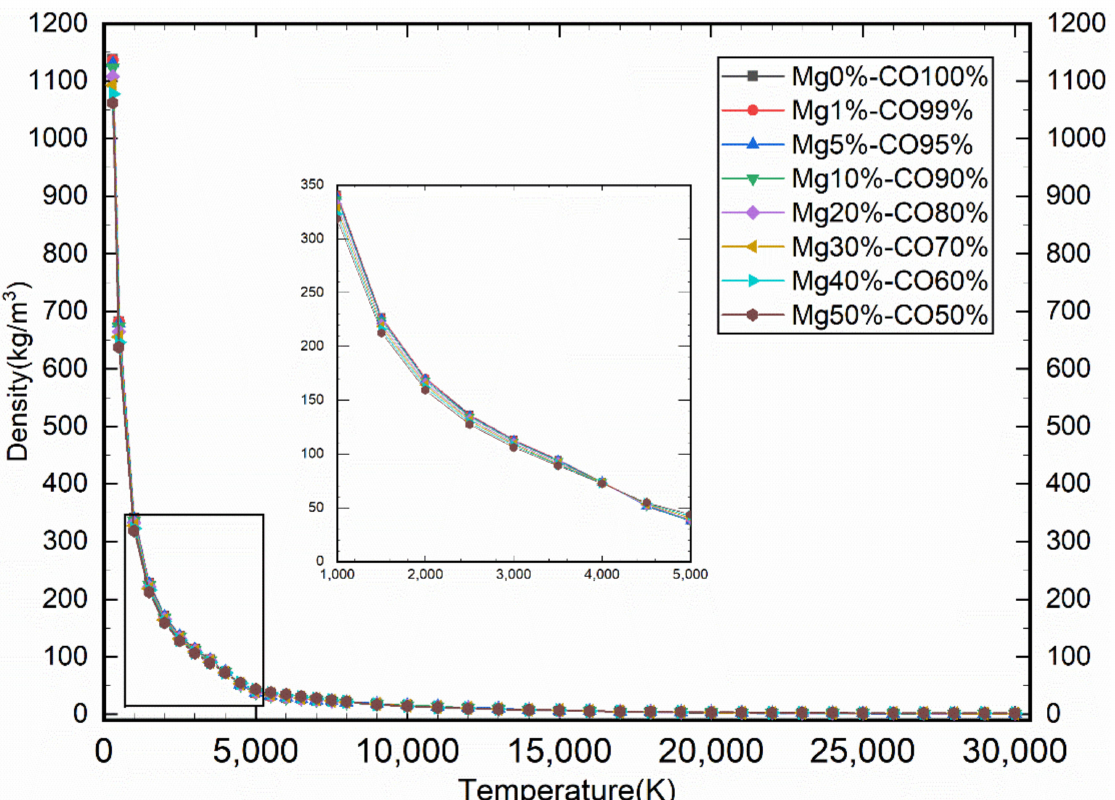
Figure 8. The curves of density for different proportion Mg-CO mixtures plasma at a temperature of 300–30,000 K and 0.1